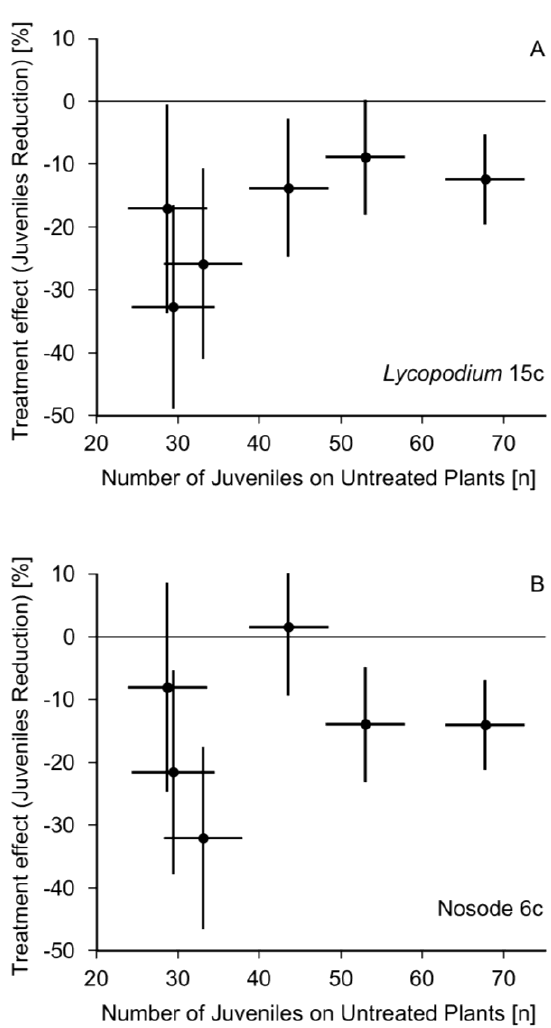
FIGURE 2 . Treatment effect size as a function of the absolute pest number for the six individual curative experiments. Treatment effect size of L. clavatum 15c (A) or nosode 6c (B) is plotted as percent juvenile offspring reduction on the y-axis (mean  SE on y-axis) as a function of the number of juveniles on untreated control plants on the x-axis (mean  SE on x-axis). Absolute pest number varied from experiment to experiment due to differences in the age of fundatrices. SE are based on the measurement values of the 10 replicates (apple seedlings) within each